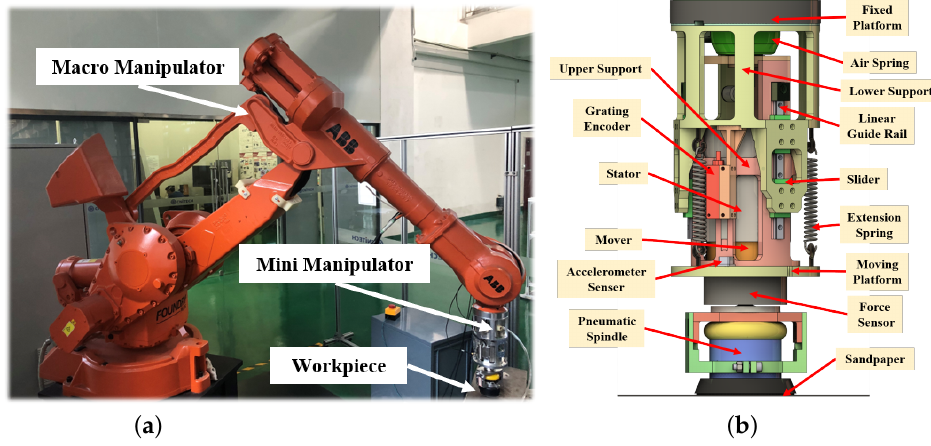
Figure 1. The composition of macro manipulator and mini manipulator: ( a ) Macro-mini manipulator for polishing. ( b ) Structure of the hybrid pneumatic-electric